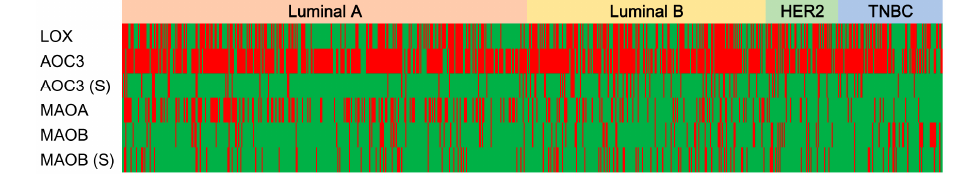
Figure 1. Heat map of amine oxidase in breast cancer molecular subtype. LOX, lysyl oxidase, AOC3, amine oxidase, MAOA, monoamine oxidase A, MAOB, monoamine oxidase B, TNBC, triple negative breast cancer, S, stroma, green, positive, red, negative.